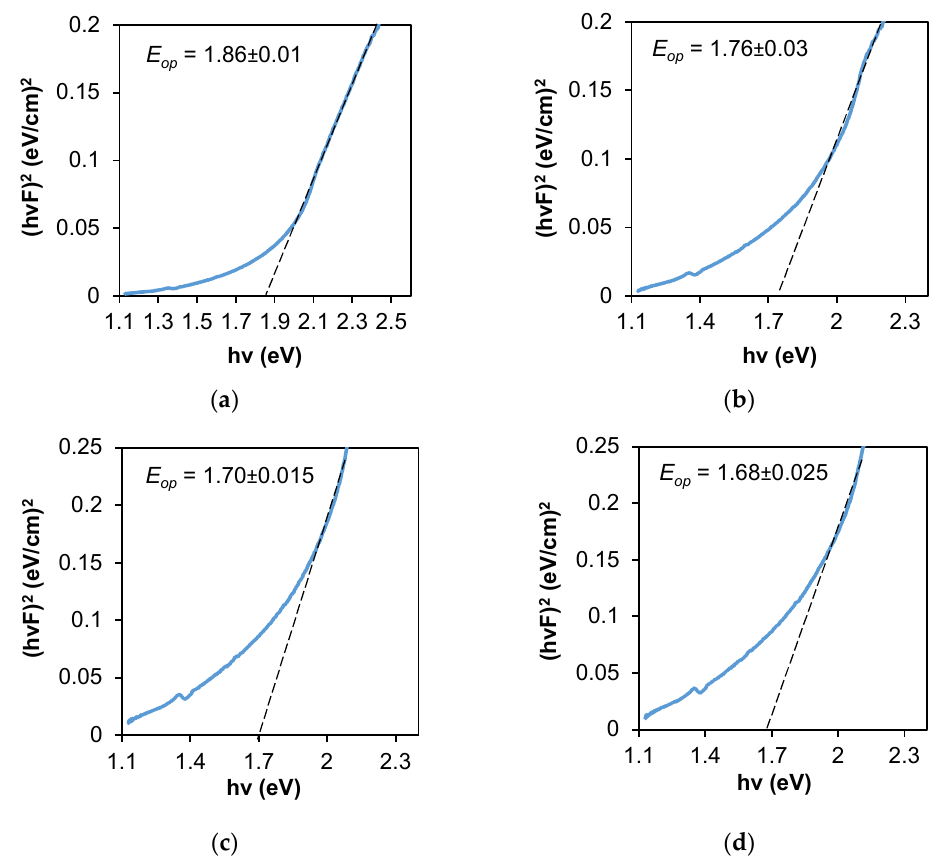
Figure 8. Optical band gap determination from diffuse reflectance spectra by the Kubelka–Munk method: ( a ) Ag–Se-6/nylon; ( b ) Ag–Se-12/nylon; ( c ) Ag–Se-24/nylon; ( d ) Ag–Se-30/nylon